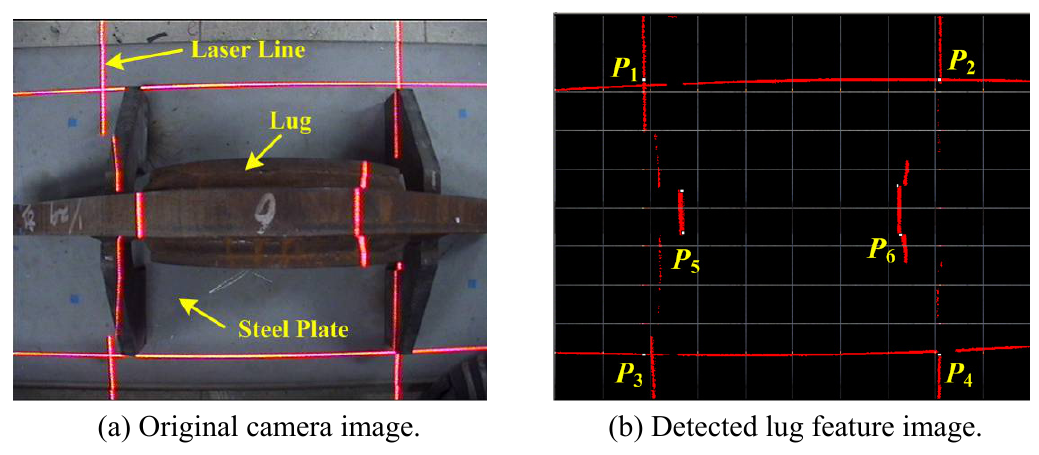
Figure 13. Results of feature extraction from the top view